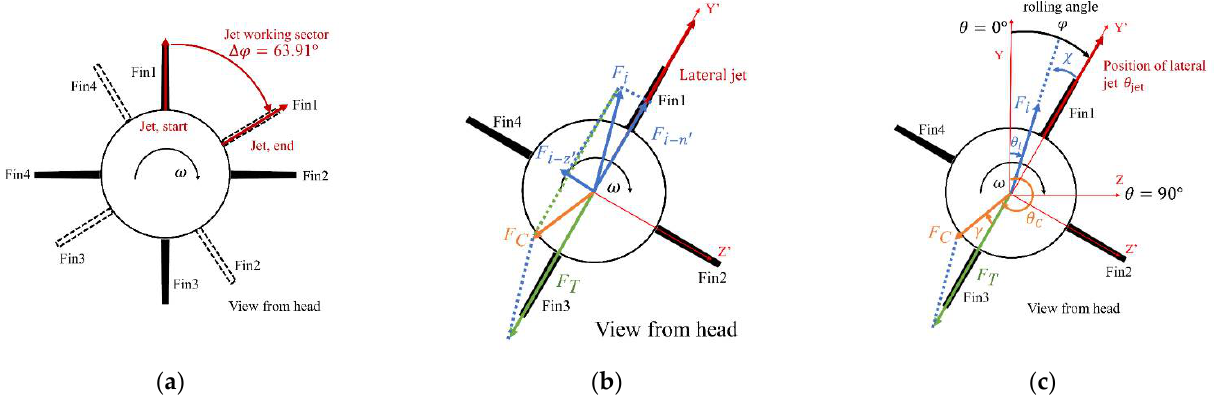
Figure 11. Schematic diagram of the jet interference force, jet control force and deflection angle: ( a ) Schematic diagram of the jet working sector; ( b ) jet interference force F i and jet control force F C during rotation; ( c ) deflection angle of F i and F C .